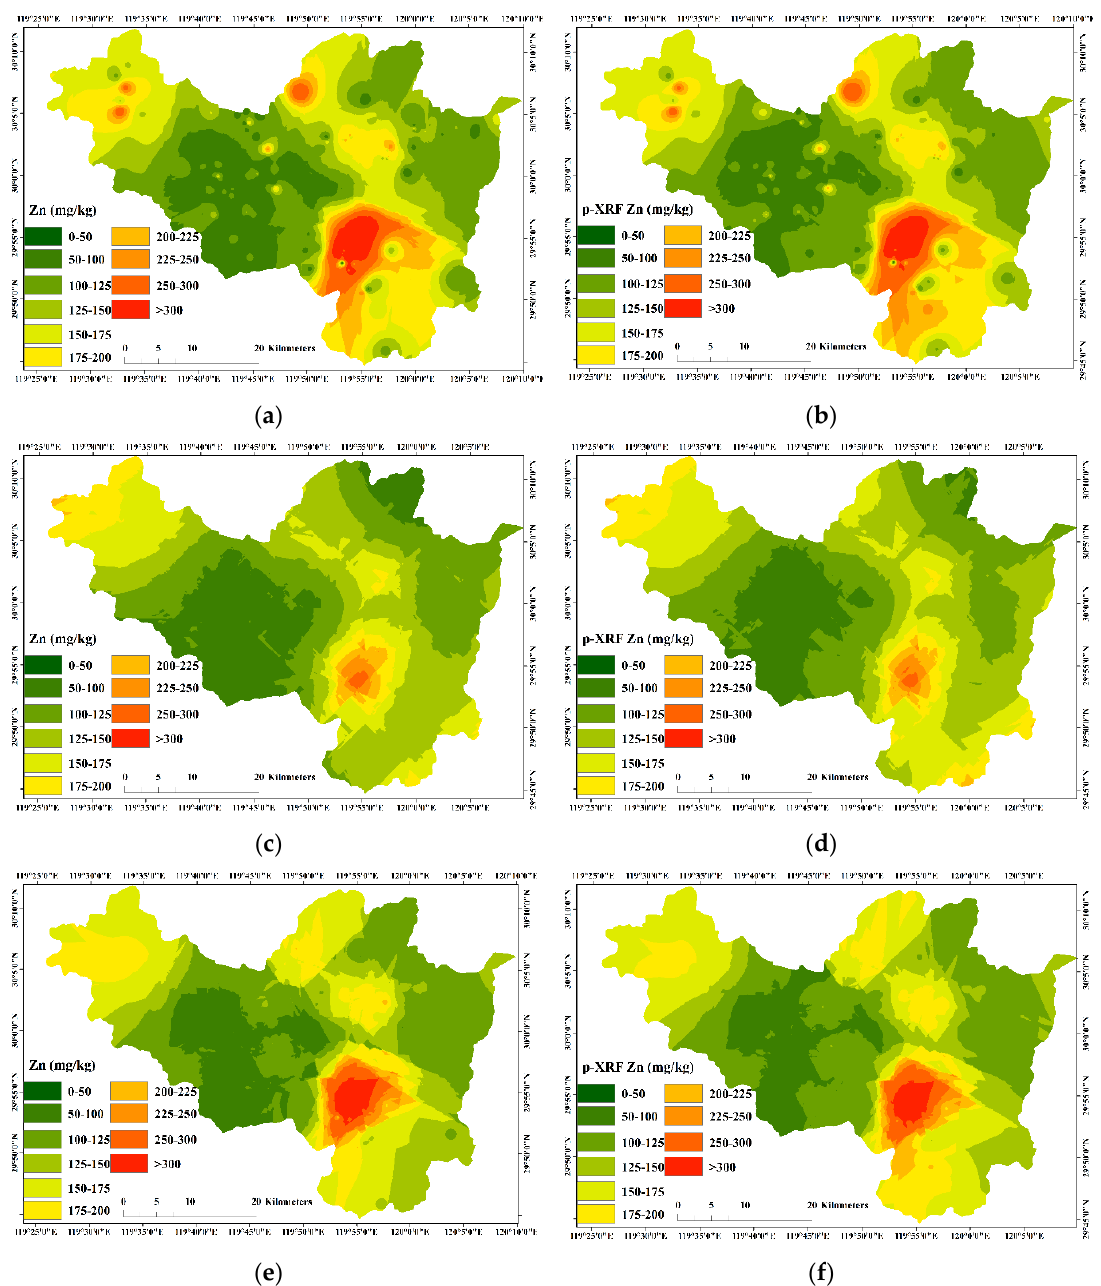
Figure 8. Maps of Zn content measured by LC-ICP-MS (left column) and p-XRF (right column) using IDW ( a , b ), OK ( c , d ), and EBK ( e , f ) geostatistical methods.